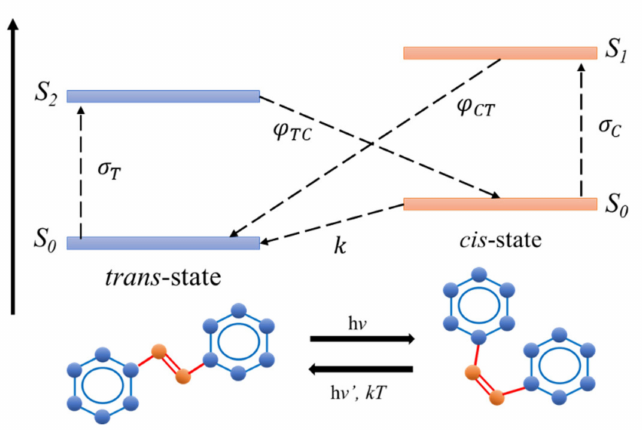
Figure 2. Four-level diagram illustrating the trans - and the cis